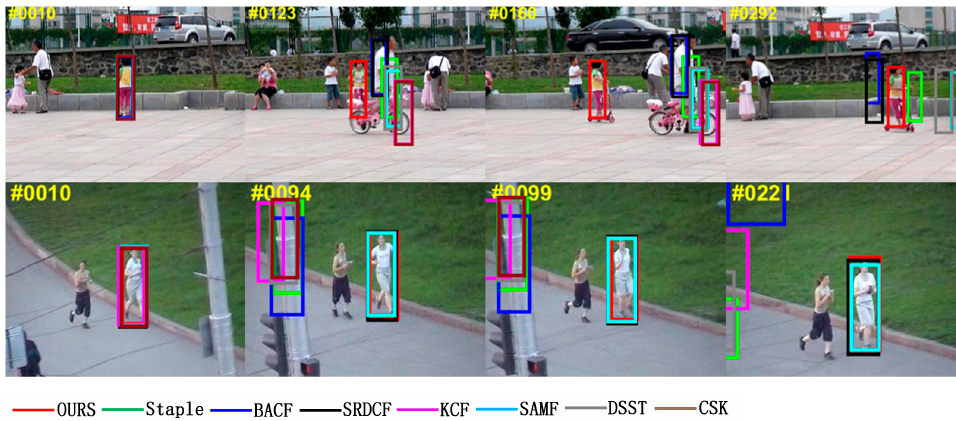
Figure 6. Visual comparison with eight trackers in the “Girl2” and “Jogging2” video sequences in an occlusion challenge scenario.